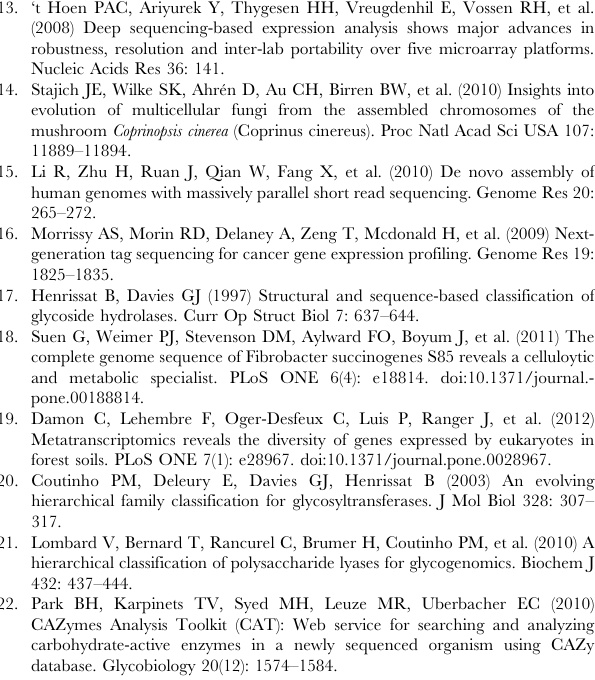
Table S6 Differentially expressed genes between in H1521 and PYd15. Table S7 Transcriptional profiles of CAZyme genes in three different strains. (XLS) Table S8 Differentially expressed CAZyme genes be- tween PYd21 and PYd15. (XLS) Table S9 Differentially expressed CAZyme genes be- tween in H1521 and PYd15. (XLS) Table S10 Differentially expressed CAZyme genes be- tween H1521 and PYd21. (XLS) Data S1 The predicted amino acid sequences of CA- Zymes in V. volvacea .